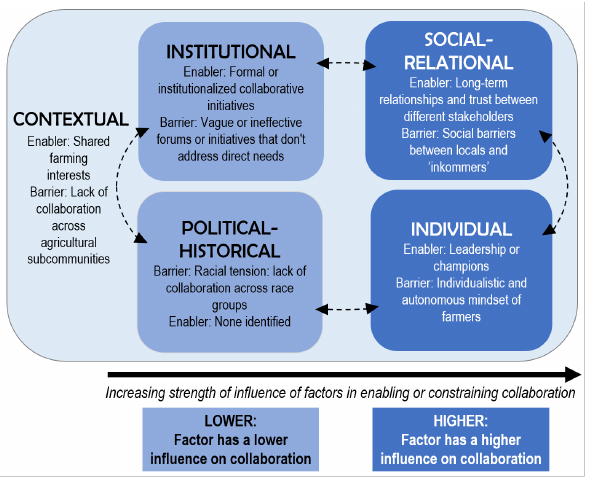
Fig. 4 . Conceptual model illustrating strength of influence of different factors (enablers and barriers) on collaboration. Individual and social-relational factors appear to have the strongest influence. Note: Examples of enablers and barriers in small font taken from Langkloof case